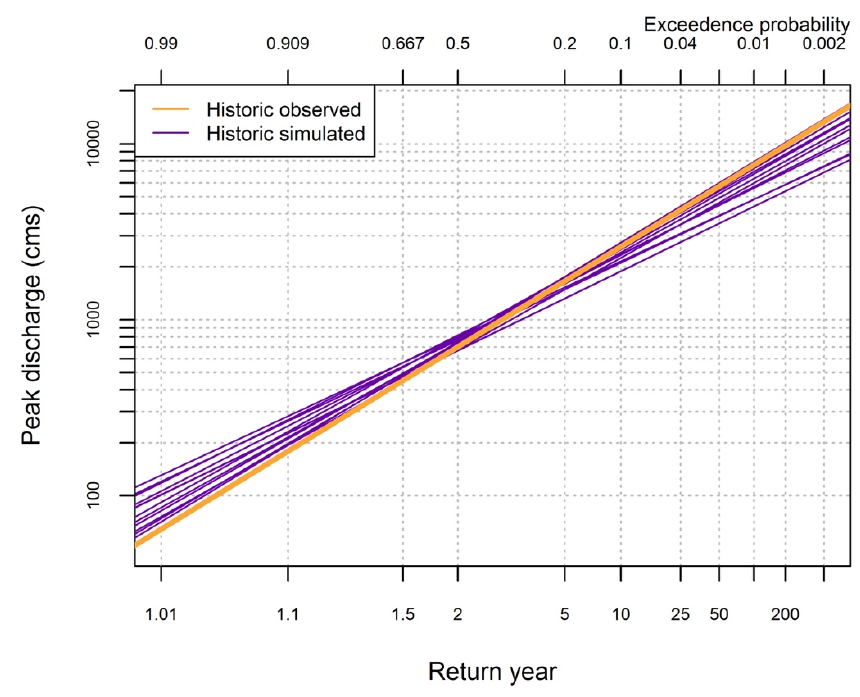
Figure 9. Expected posterior flood frequency curves derived from observed streamflow data (orange) and GCMs forced with observed parameters from 1950–1999 (purple).